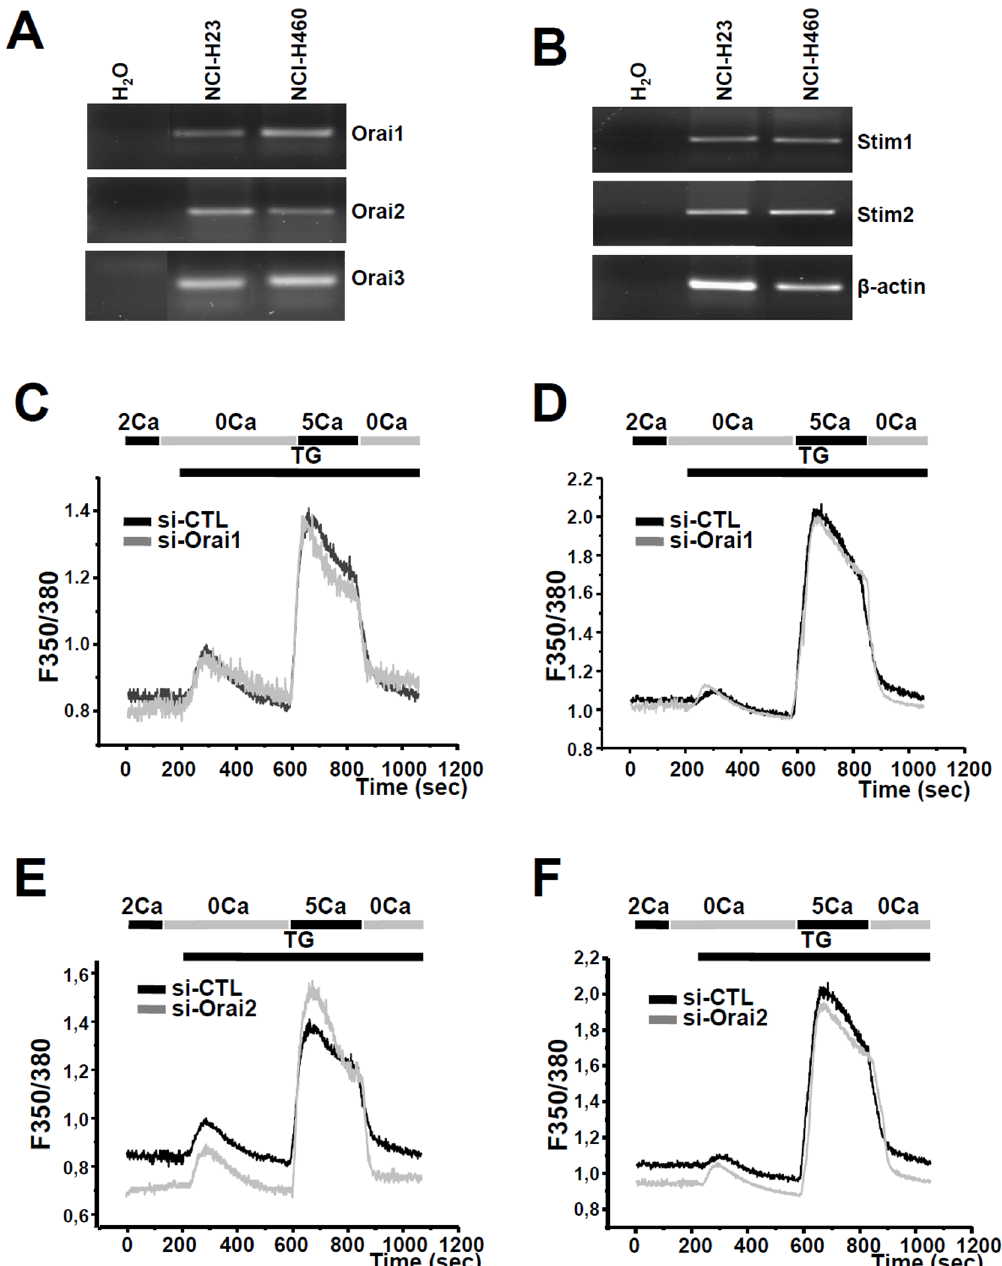
Figure 3. Silencing of Orai1 and Orai2 does not change SOC entry in the two cell lines. Expression of Orai1, Orai2, Orai3, Stim1, and Stim2 estimated in NCI-H23 (A) and NCI-H460 (B) cells using semi-quantitative RT-PCR. si-Orai1 has no effect on SOCE in NCI-H23 (C, n=125) and NCI-H460 (D, n=150). Silencing Orai2 (si-Orai2) induces increase in SOCE in NCI-H23 (E, n=125, p , 0.001, Mann-Withney test), but has no effect on SOCE in NCI- H460 (F, n=125) cells. doi:10.1371/journal.pone.0072889.g003 NCI-H460 lung cancer cells. Orai3 silencing led to cell cycle arrest, with cell accumulation in the G0/G1 phase (61.4 6 2.7% vs 48.8 6 2.8%, p , 0.001 for NCI-H23, Fig. 5C, and 68 6 3.4% vs 52 6 5.1%, p , 0.001 for NCI-H460, Fig. 5D). At the same time, a decrease in cell number in S and G2/M phases has been observed (Fig. 5C–D). These data demonstrate that Orai3 knockdown